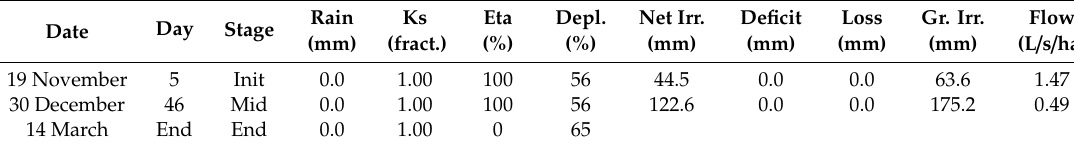
Figure 2. Irrigation schedules for wheat. Table 8. Irrigation schedules for barley.